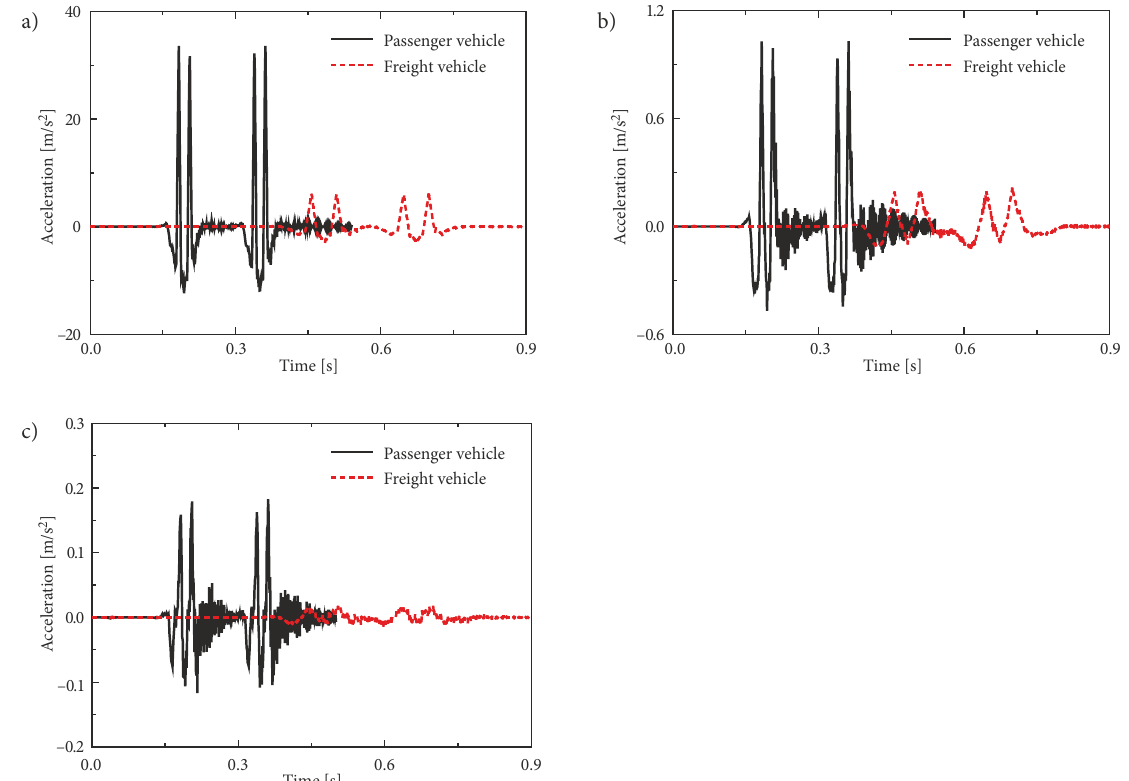
Figure 6. Accelerations of track structures: a – rail acceleration; b – concrete slab acceleration; c – supporting layer